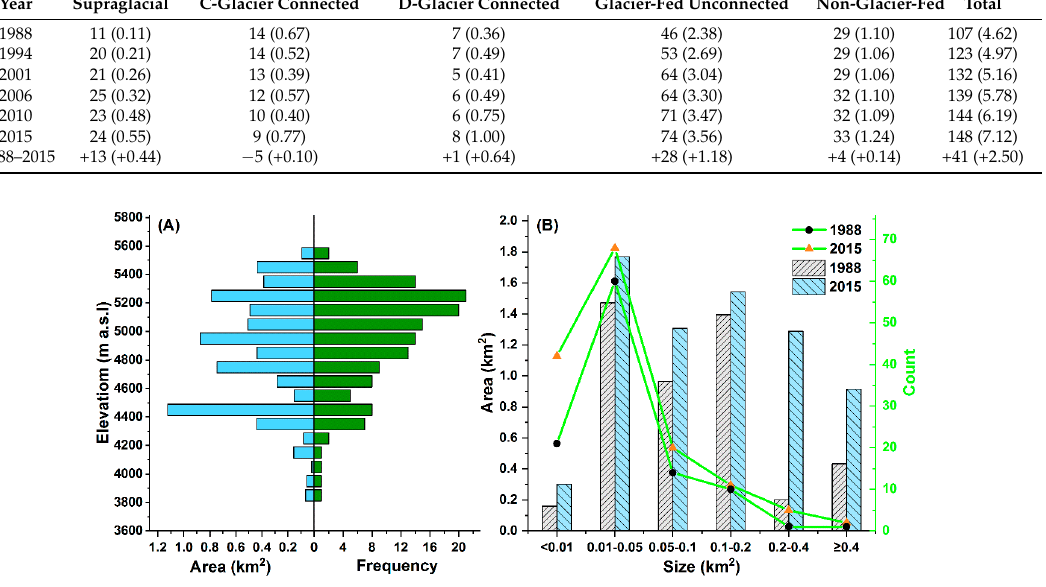
Figure 8. Characteristics of altitudinal distributions and size groups of glacial lakes: ( A ) altitudinal distributions in area and frequency for glacial lakes in 2015; ( B ) area and frequency distributions of glacial lakes among size classes in 1988 and 2015.